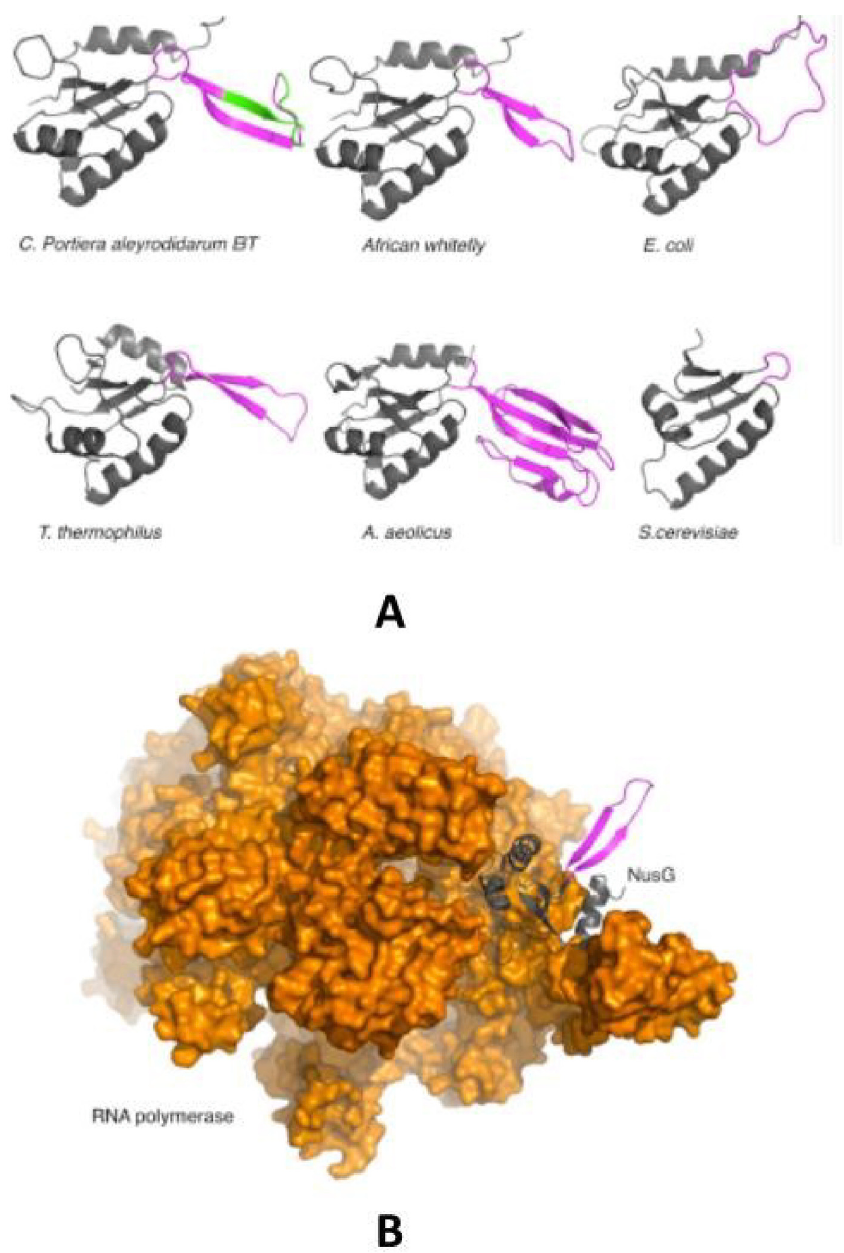
Figure 4. Structure analysis of Nus G from P. aleyrodidarum in B. tabaci and other endosymbionts. A . Phyre2 based structure prediction of Nus G from Candidatus Portiera aleyrodidarum in B. tabaci SSAI whitefly and comparisons to the structures of Nus G from other bacterial species as indicated and of Spt4/5 from yeast. Nus G is coloured in grey, the loop region in magenta and the 11-residue deletion is shown in green in the C. Portiera aleyrodidarum structure. B . A model of bacterial RNA polymerase (orange surface representation) bound to the N-terminal domain of the T. thermophiles Nus G (grey cartoon